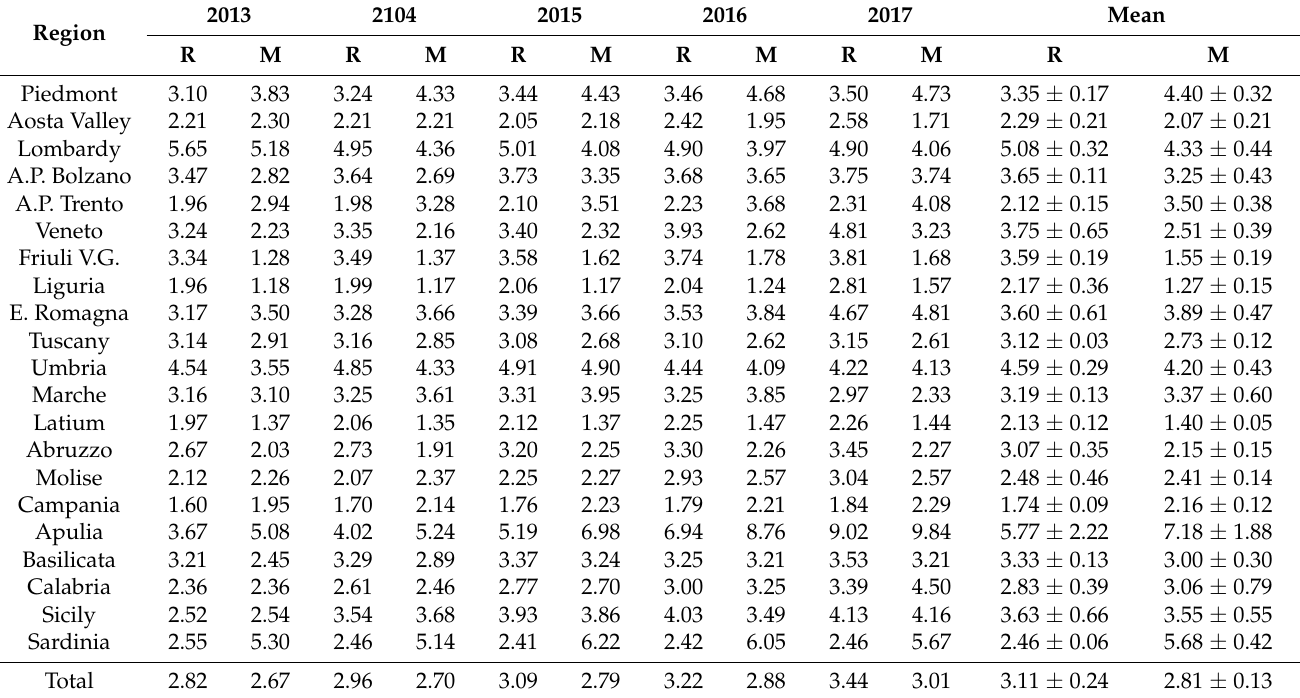
Table 2. ORD/DH rate of Italian regions, residents, and mobility,